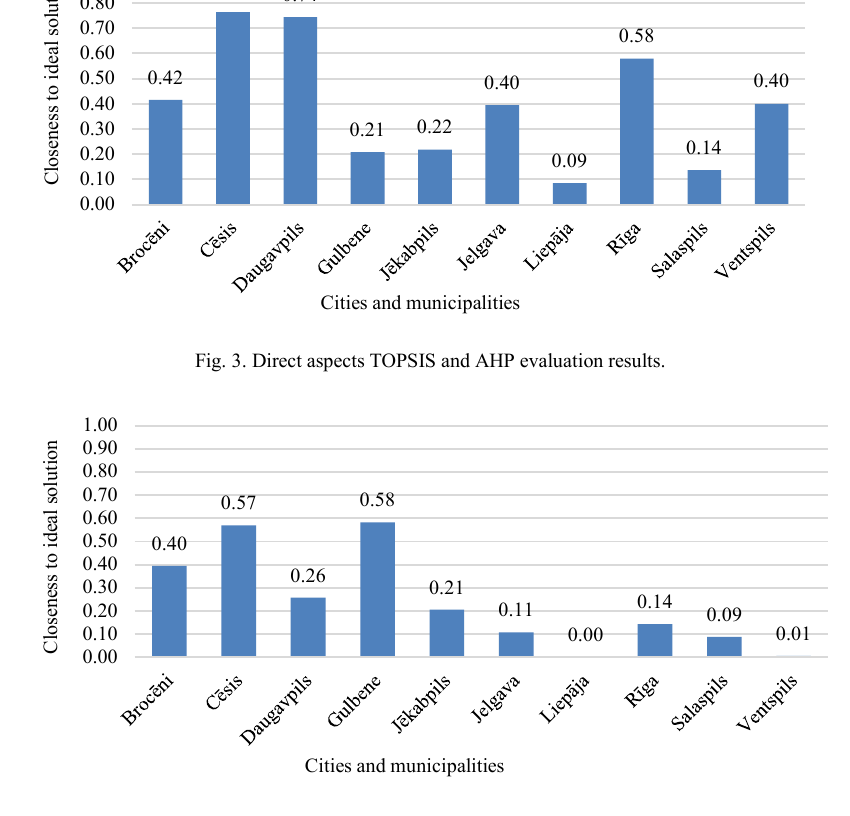
Fig. 4. Indirect aspects TOPSIS and AHP evaluation